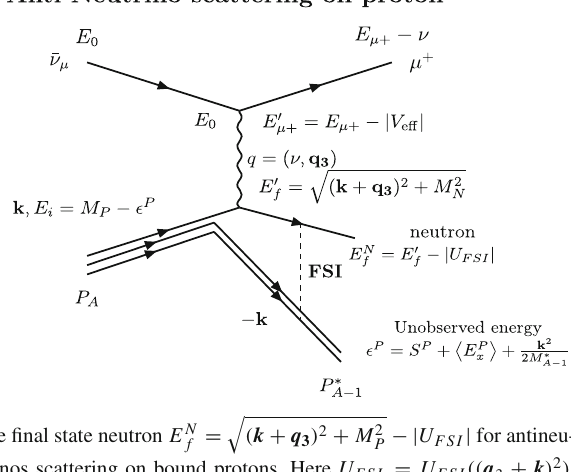
(cid:6) + k 2 . x 2 M ∗ A − 1 (cid:6) ) 2 + M 2 − | U | + ( k + q 3 FSI P